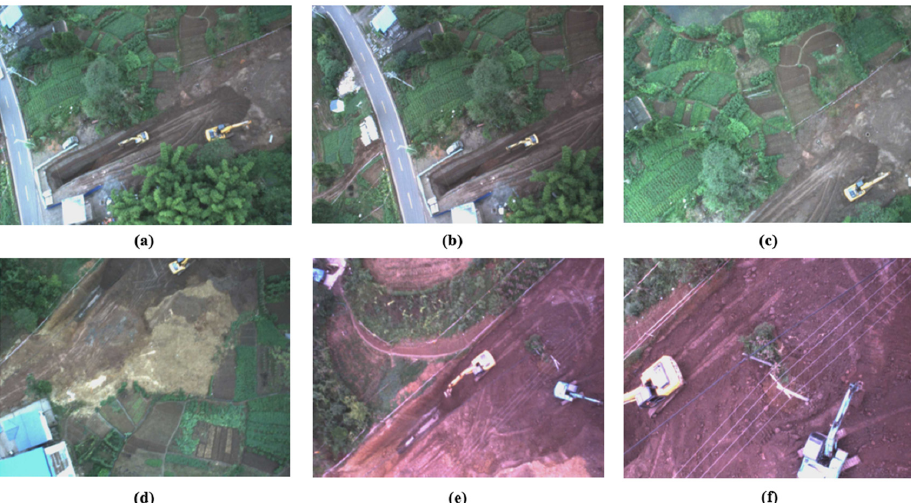
Figure 11. Images with detected excavators transmitted to the Warning Module during the UAV remote sensing experiment. The images were in di ff erent situations: ( a ) containing two excavators at Site A; ( b ) containing a small excavator at Site A; ( c ) containing an excavator in the corner of the image at Site A; and ( d ) containing a portion of an excavator at Site B. ( e , f ) containing the same excavators but acquired at di ff erent flight altitudes at Site B. All images were acquired at flight altitudes of 120 m, except ( f ), the altitudes of which was 60